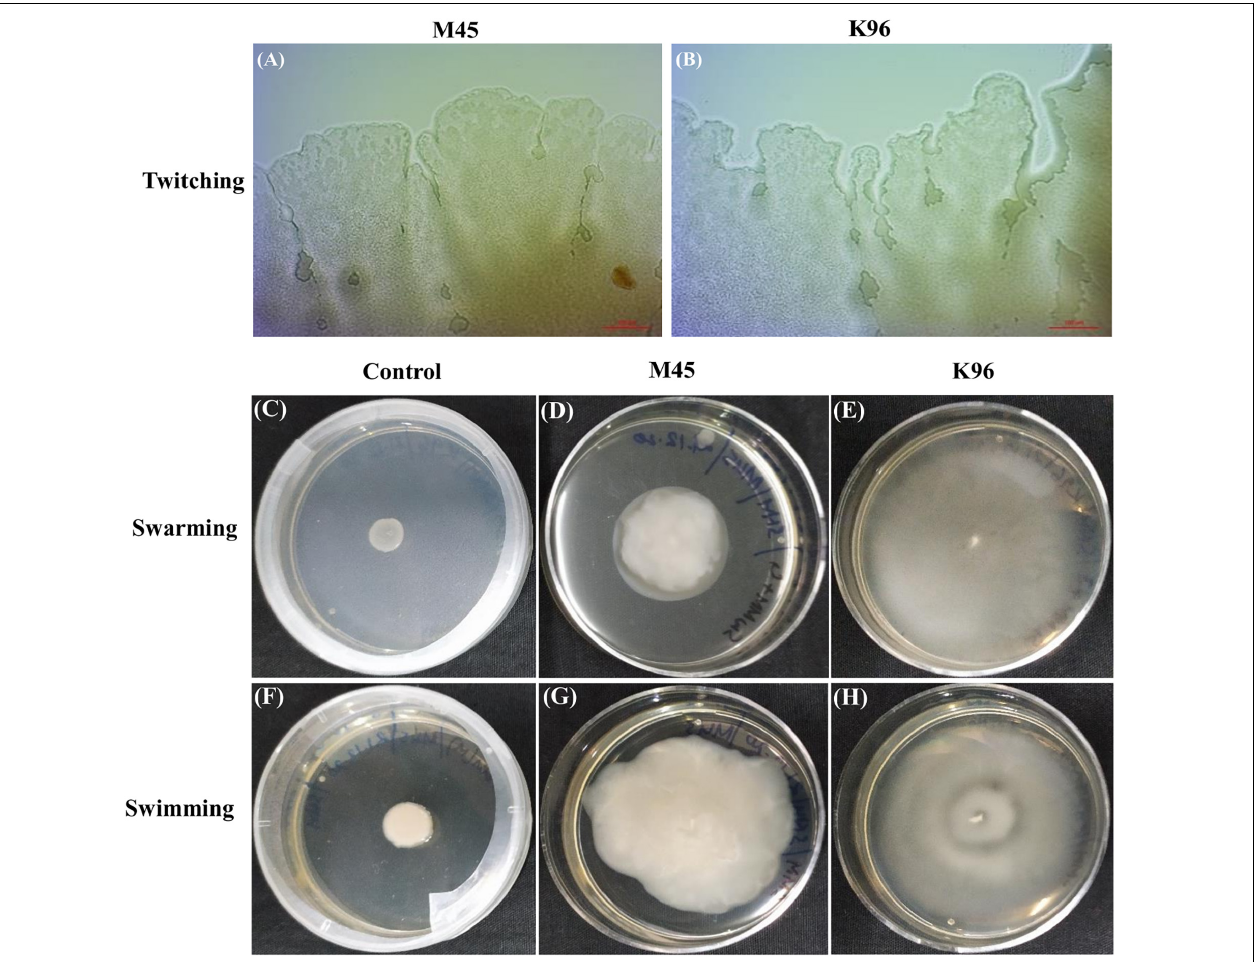
FIGURE 6 | Motility assays. (A,B) Light microscopy of colony edges of M45 and K96 in twitching motility. Both M45 and K96 isolates produced a flat, widely spread, irregularly shaped colony at 100X magnification. (C–E) Swarming motility [NA plate with 5 g glucose/L and 0.5% (w/v) agar] and (F–H) Swimming motility [LB with 0.3% (w/v)] of Control, M45 and K96 incubated at 28 ◦ C for 48